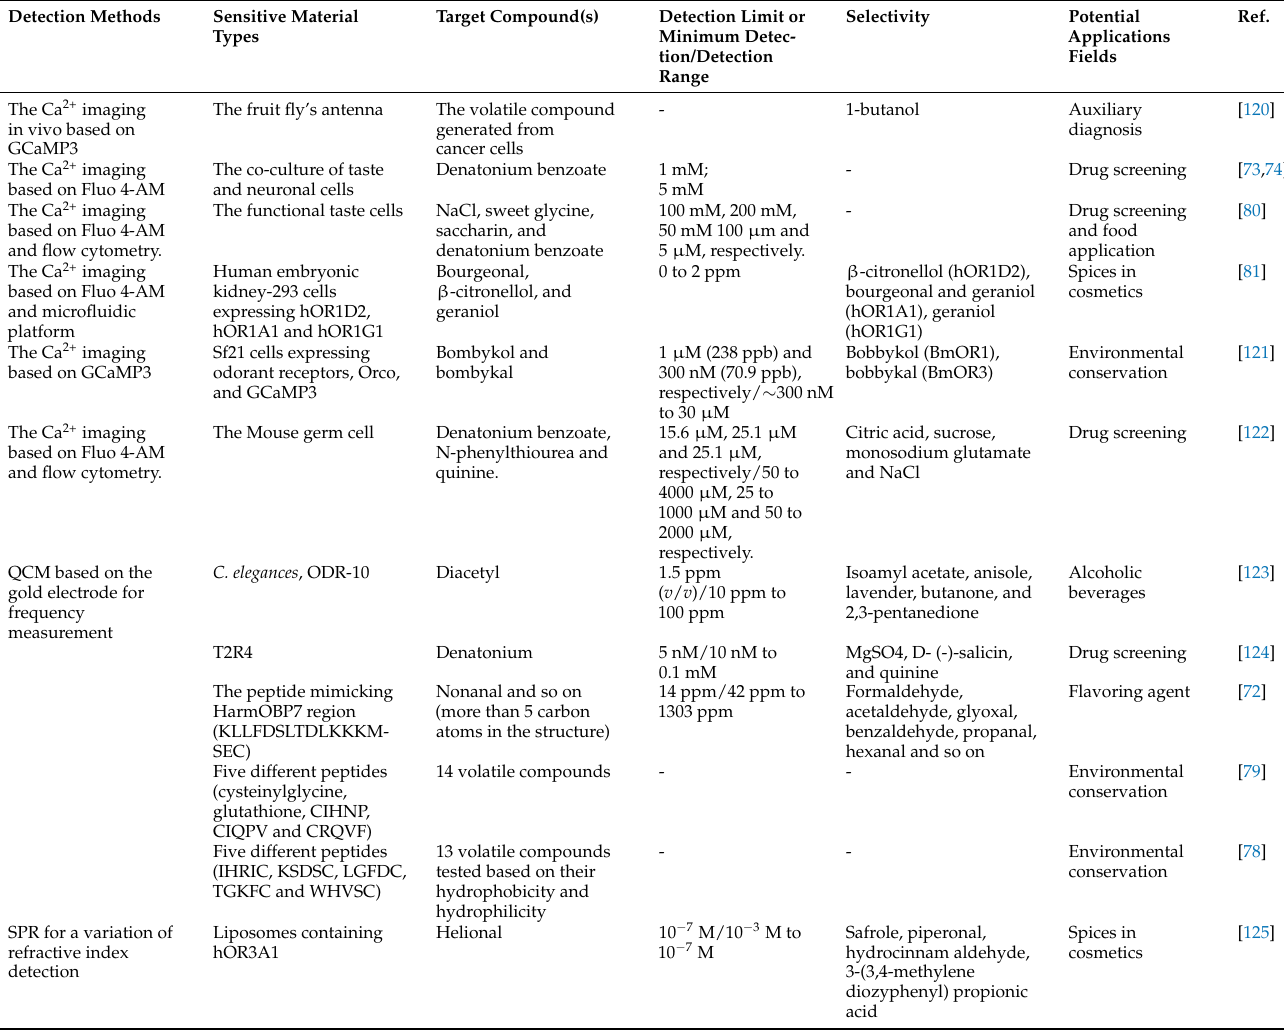
Table 4. Summary research of detection strategies on biomimetic olfactory and gustatory biosensors based on Ca 2+ imaging and